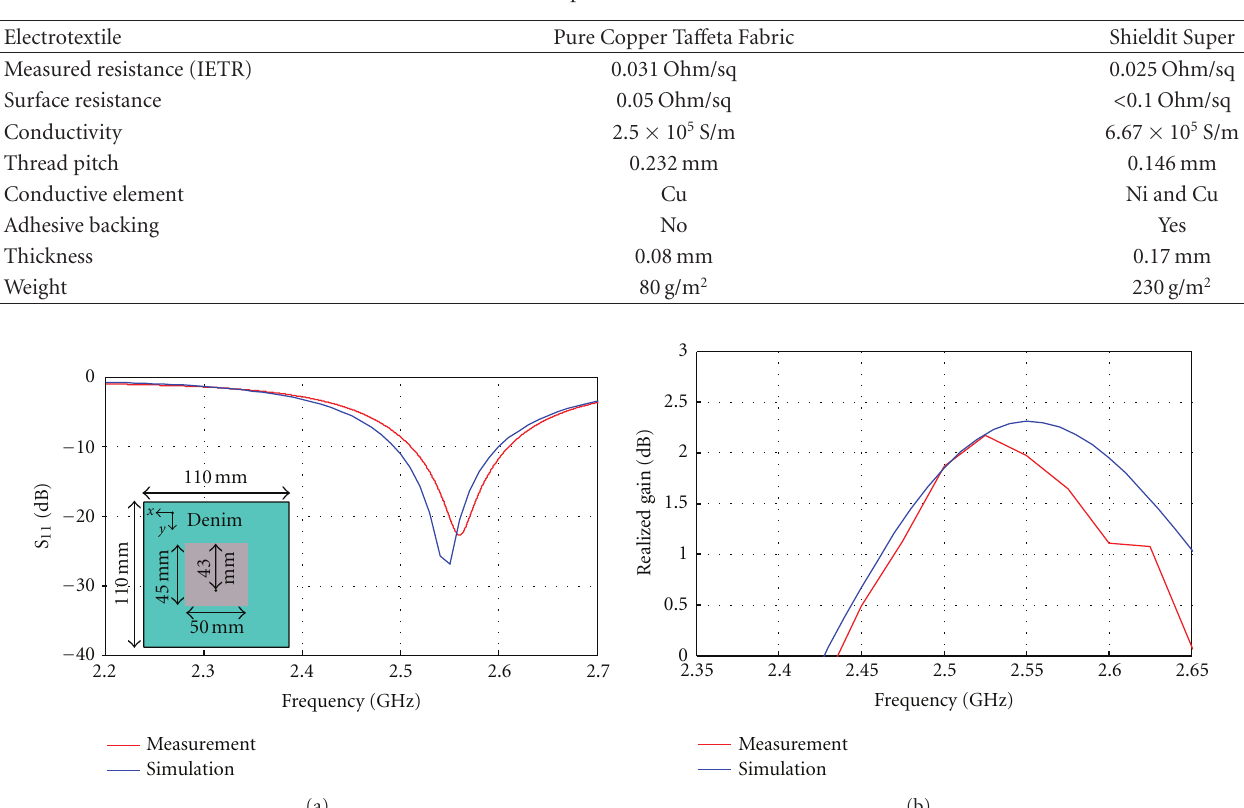
Table 1: Properties of electrotextiles.